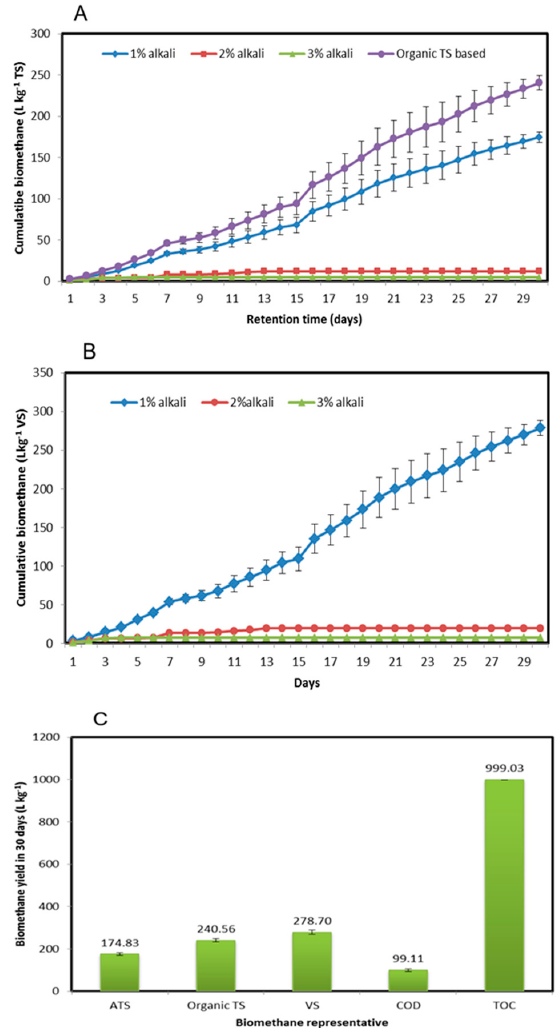
Figure 4. Biomethane yield in batch BMP experiment of AHTPW of alkaline hydrothermal pretreated corn residue. ( A ) cumulative yields in TS basis; ( B ) cumulative yields in VS basis; ( C ) 30 days’ total production of 1% alkali pretreated CR represented in various forms.